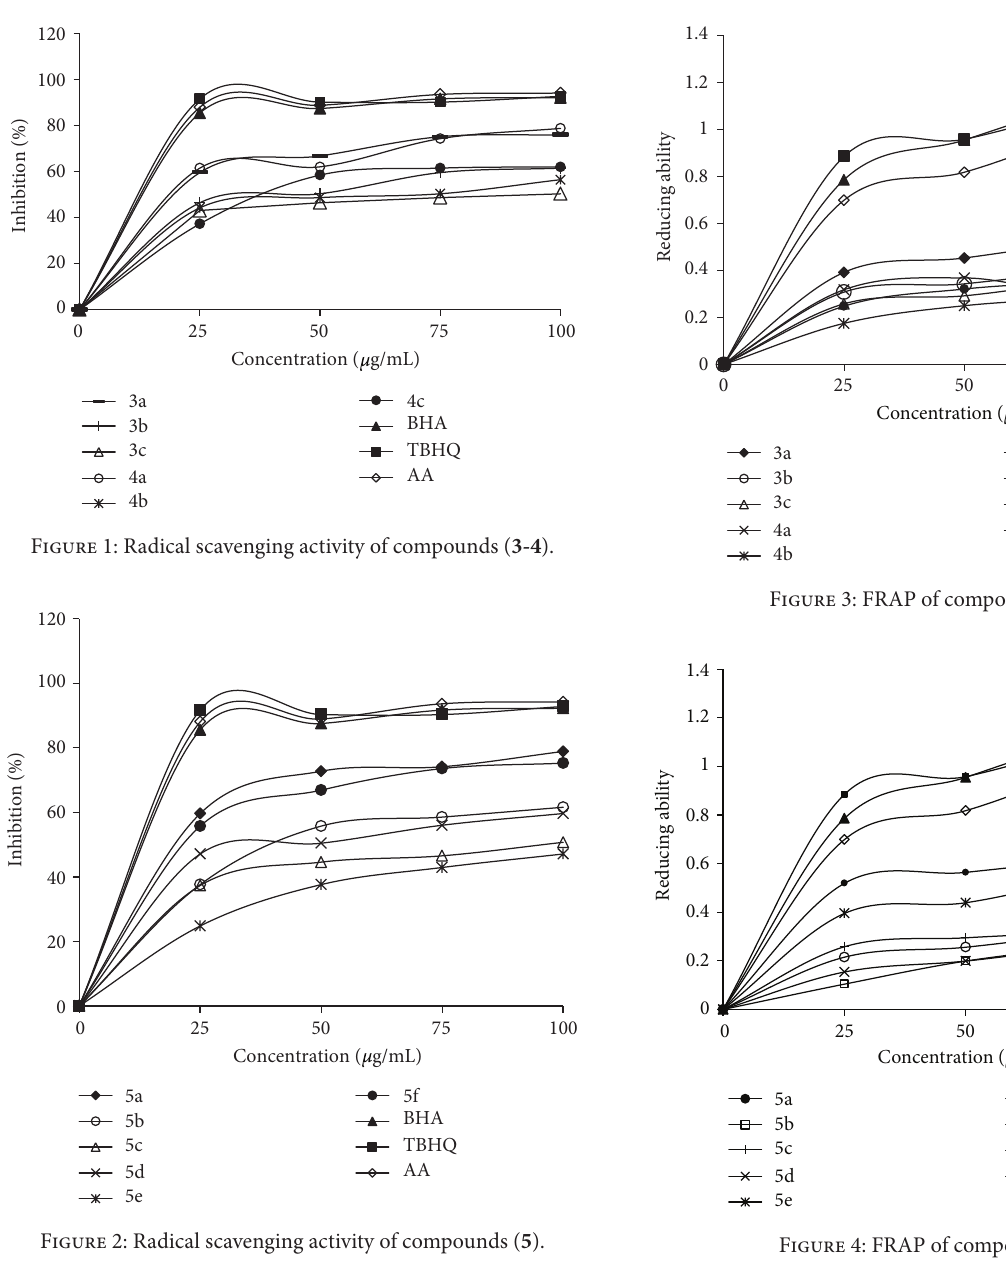
F 4: FRAP of compounds ( 5